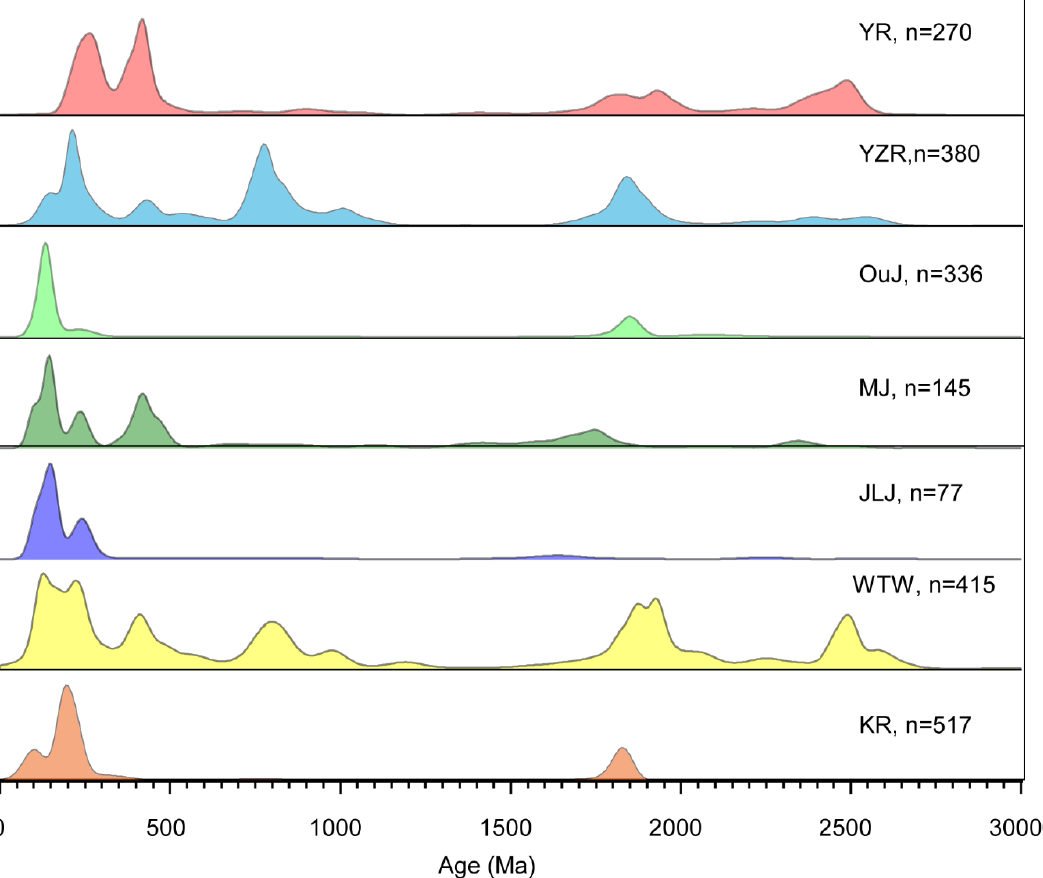
Figure 3. Normalized kernel density estimates (KDEs) of U-Pb age distribution in sediments of seven rivers flowing into the ECSs. The age numbers (n) are shown along the KDE distributions. Abbreviations: YR (Yellow River), YZR (Yangtze River), OuJ (Ou Jiang), MJ (Min Jiang), WTW (rivers in western Taiwan) and KR (Rivers in South Korea). Table 2. Mixing coefficients of five important river sources in the east China seas.